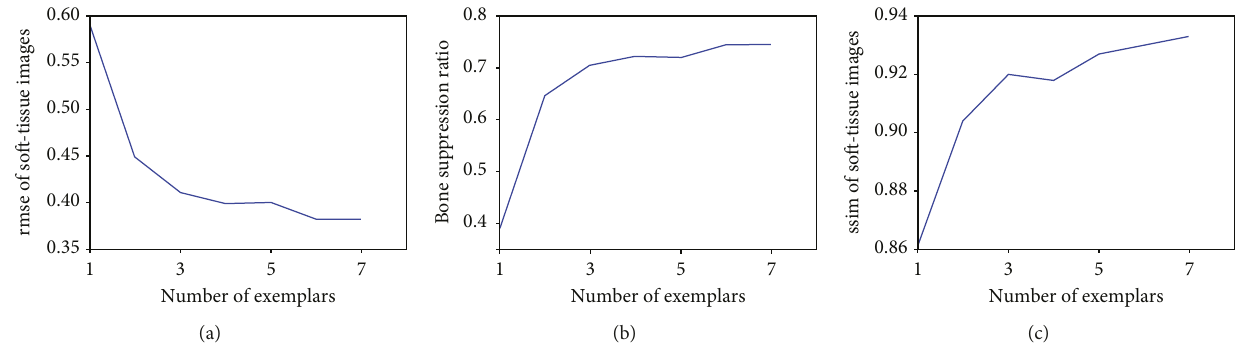
S for kernel density estimation.